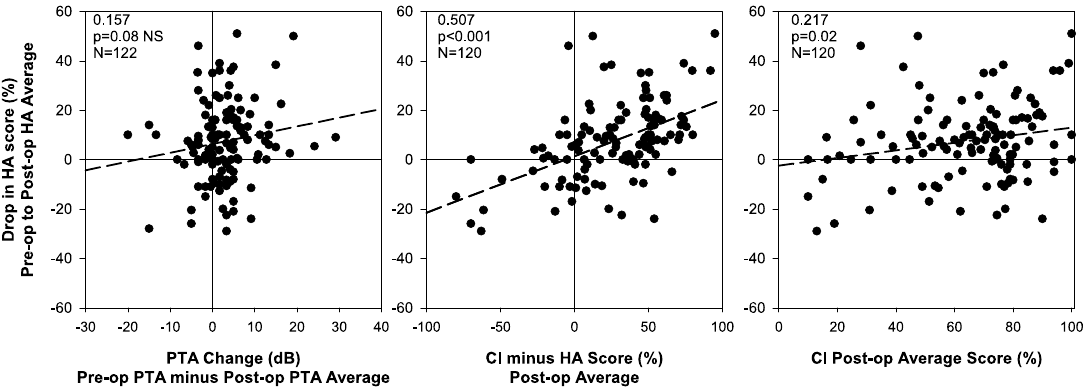
Figure 4. Drop in postoperative speech perception scores in the nonimplanted ear as a function of: change in pure-tone average (left panel), implanted ear advantage (or degree to which speech perception is better in the implanted than in the nonimplanted ear, center panel), and speech perception score in the implanted ear (right panel).